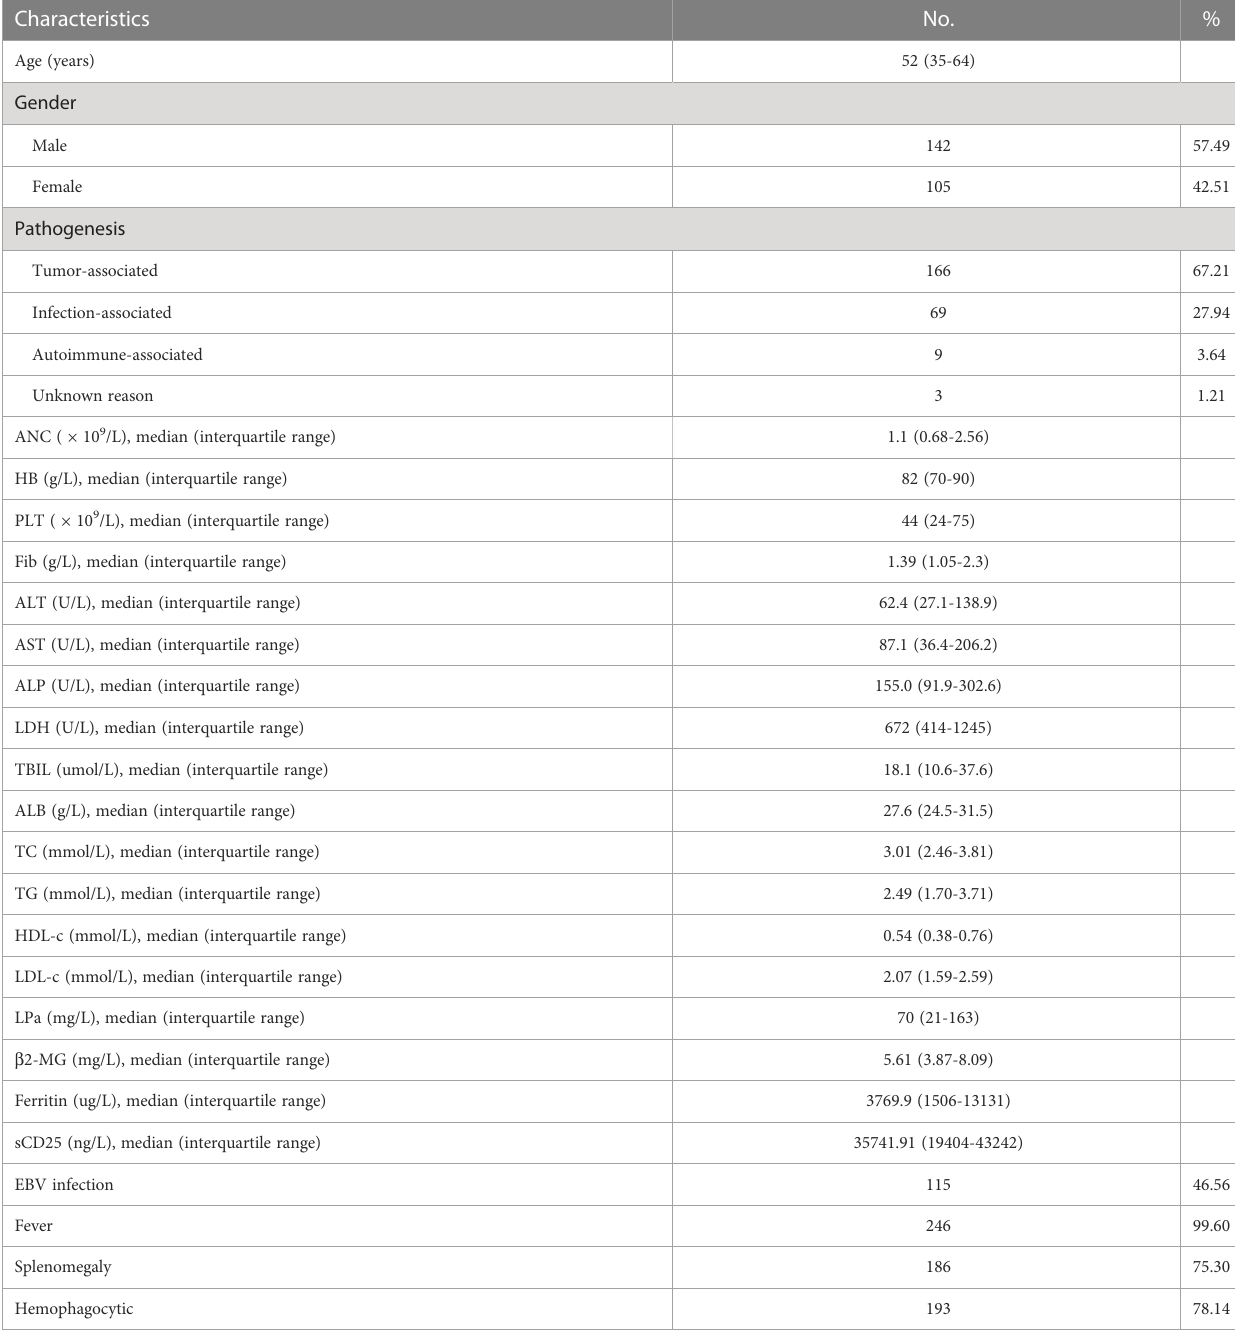
TABLE 1 Baseline characteristics of 247 patients with